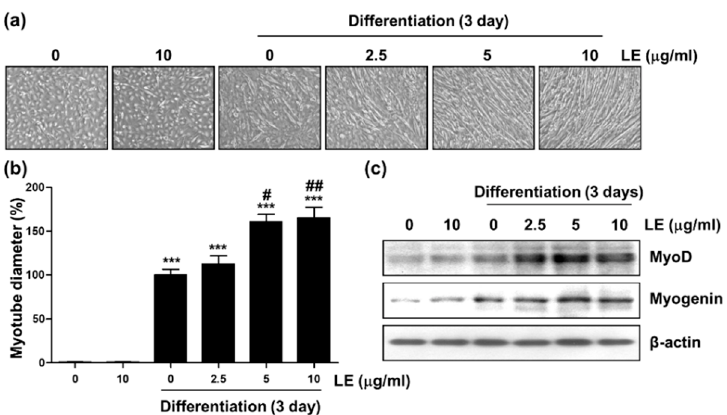
Figure 10. Effect of loquat leaf extract (LE) on C2C12 myoblast differentiation. The pre-differentiation step involved incubation for 2 days in differentiation medium that included 2% horse serum. Then, LE was added to the differentiation medium to induce myoblasts differentiation for 3 days: ( a ) Representative images of C2C12 cells. Cells were cultured for 3 days in differentiation medium, with or without LE. Representative results of three independent experiments are shown; ( b ) Effect of LE on myotube diameter after 3 days of differentiation. Data indicate mean ± SD values ( n = 3; *** p < 0.001 vs. control cells; # p < 0.05 and ## p < 0.01 vs. differentiated control cells); ( c ) Expression levels of MyoD and myogenin. Western blot analysis was performed using β -actin as a loading control. Representative results of three independent experiments are shown. MyoD, myogenic differentiation 1.